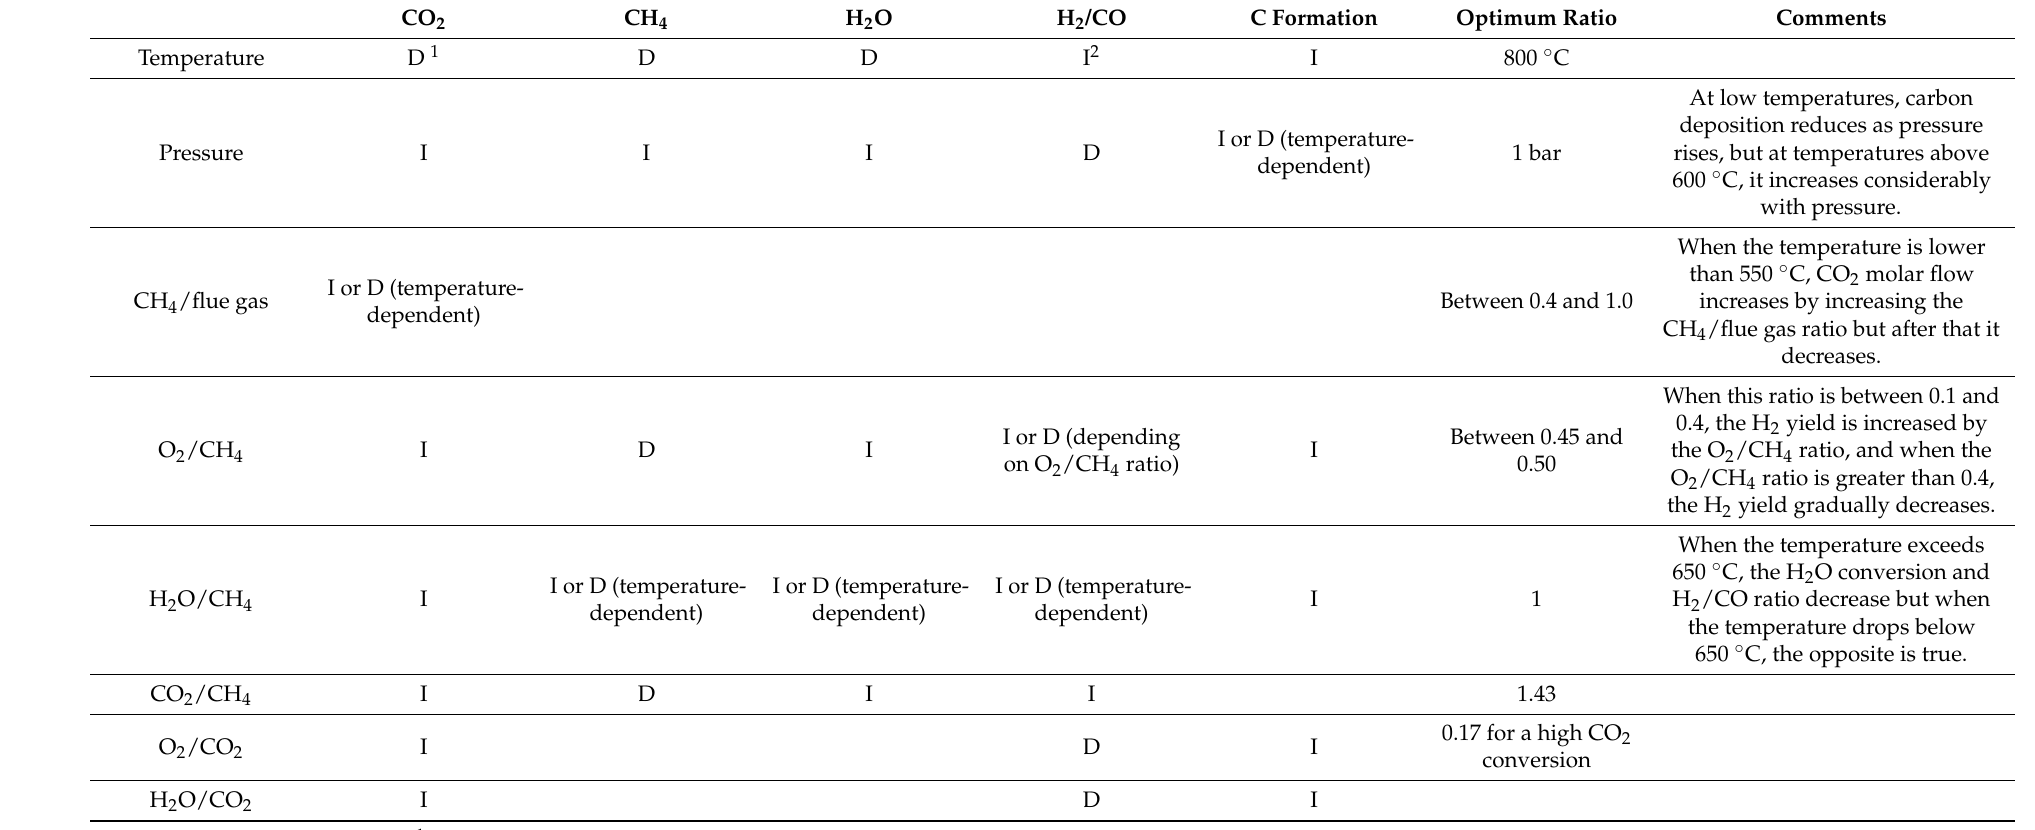
Table 3. Effect of various operational parameters on feed gas conversions and H 2 /CO